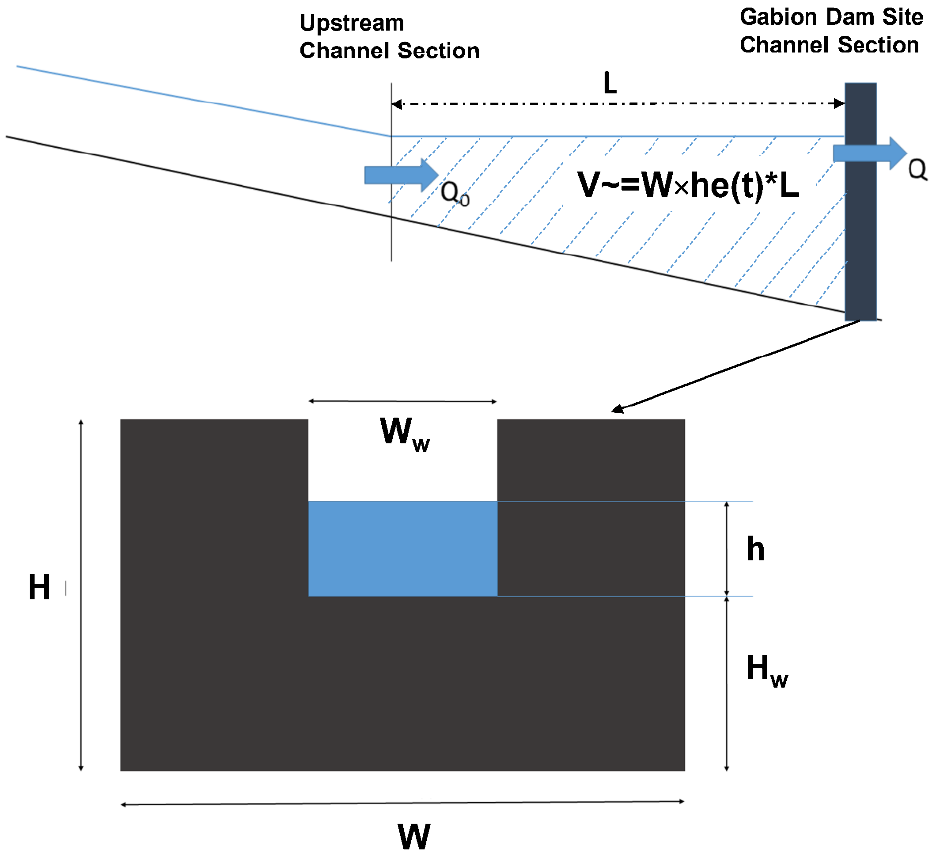
Figure 6. Longitudinal cross-section of a detention basin ( upper panel ) and front section of a gabion dam ( lower panel ). Dimensions are as shown in the